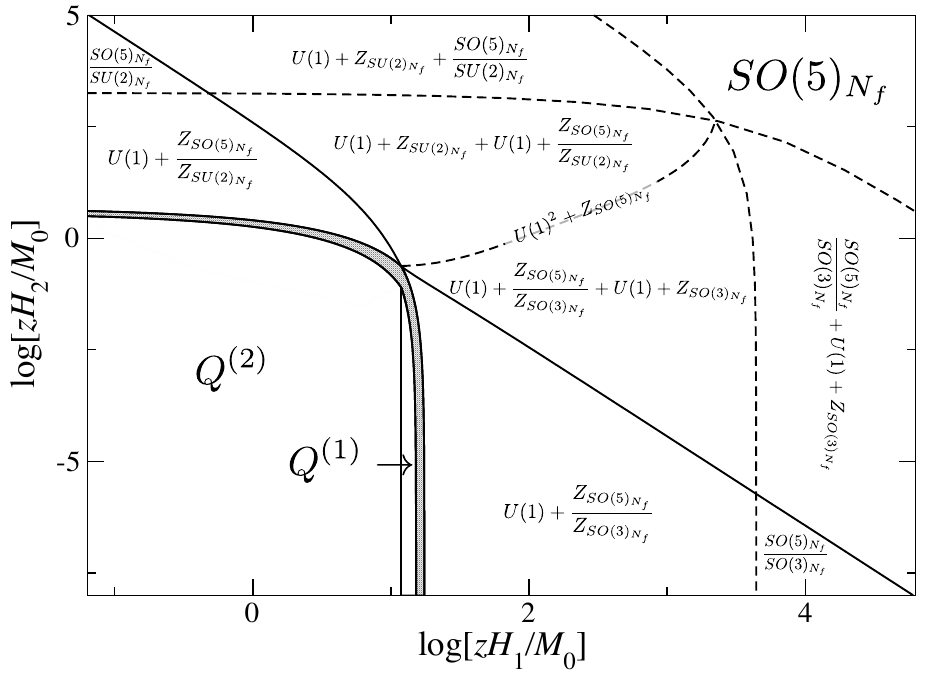
Figure 7 . Contribution of the SO(5) N anyons to the low-temperature properties of the model (1.1), f see (cid:12)gure 2 for the phases of the solitonic quasi-partiles: using the criteria described in the main text the parameter regions are identi(cid:12)ed using analytical arguments for T ! 0 (the actual location of the boundaries is based on numerical data for p 0 = 2 + 1 = 3 and T = 0 : 035 M 0 ). For small (cid:12)elds (regions Q (1) , Q (2) ) a dilute gas of non-interacting quasi-particles with an internal anyonic (zero- energy) degree of freedom with quantum dimension Q (1) or Q (2) is realized. In the shaded region The degeneracy of the zero modes is lifted by the presence of thermally activated solitons with a small but (cid:12)nite density. All the other phases are labelled by the CFT describing the collective state formed by the condensed degrees of